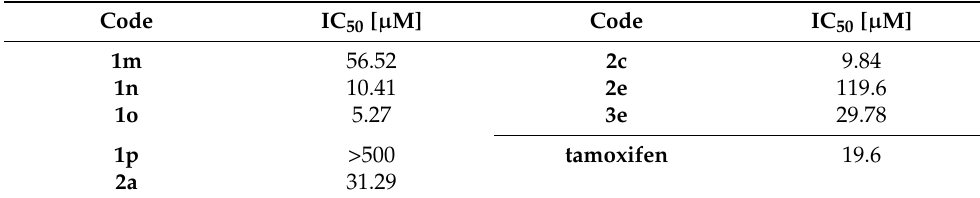
Table 5. Cytotoxicity of the selected derivatives 1 – 3 towards HepG2 cell